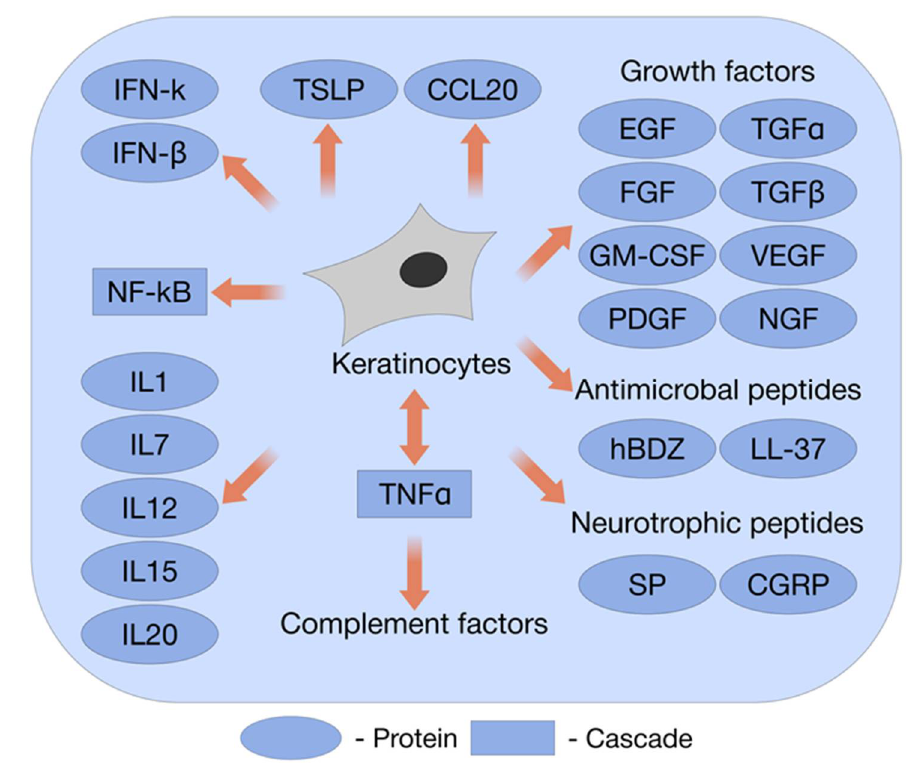
Figure 1. Scheme of key regulatory factors of healthy epidermal keratinocytes under normal and inflammatory conditions. Transforming growth factor- α (TGF- α ), heparin-binding epidermal growth factor (HB-EGF), and insulin-like growth factor 1 (IGF-1) were shown to be essential for KC migration [21]. Different neurotrophins, with the most abundant being nerve growth factor (NGF), brain-derived neurotrophic factor (BDNF), and glial-cell-line-derived neurotrophic factor (GDNF), are involved in the regulation of KC proliferation, migration, and apoptosis [22]. The specific expression of the cytokines and chemokines C-C motif ligand 2, 20, and 22 (CCL2, 20, and 22) and CXCL1, 8, and 12 by KCs determines the immune response [23]. KCs manage the recruitment of the T-cell skin population to sites of damage through TNF α and IL-1 α expression. They also realize a systemic shift in the T-cell response type through the thymic stromal lymphopoietin (TSLP) stimulation of Langerhans cells [24]. Neural calcitonin-gene-related peptide (CGRP) was shown to enhance keratinocyte proliferation and, together with substance P (SP), induce the inflammatory response of KCs [25]. Thus, the whole network of KCs involved in these processes is